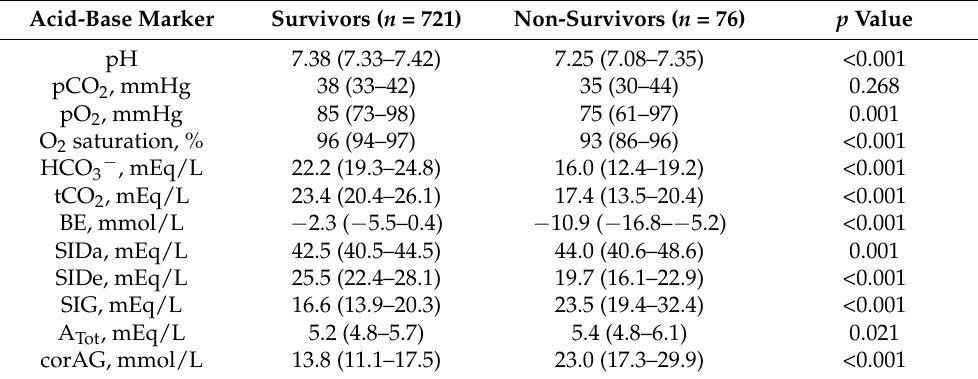
Table 2. Differences in variables associated with acid-base balance and parameters assessing acid-base status in survivors and non-survivors on the first day ( n = 797).